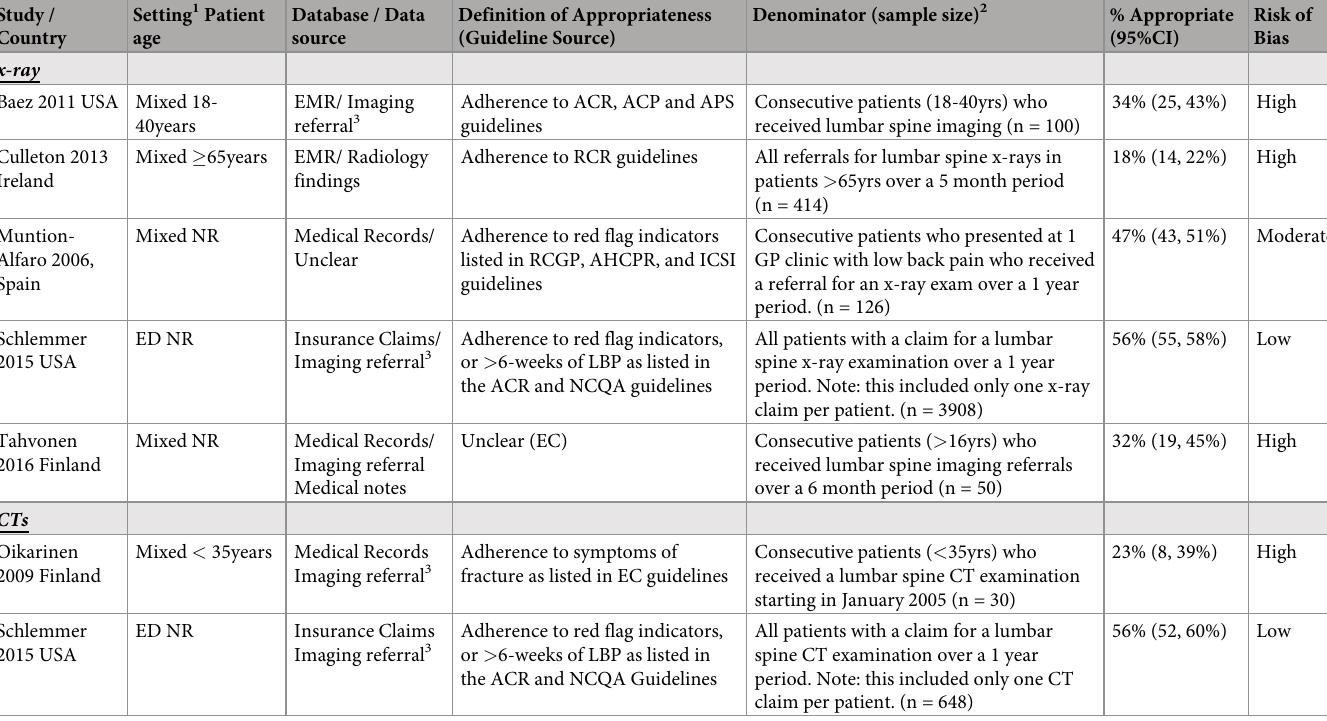
Table 1. Study characterised and reported outcomes of appropriateness organised by image